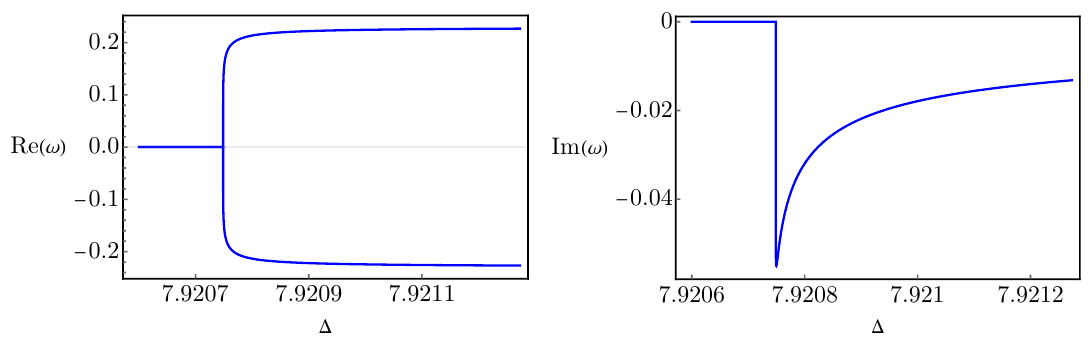
Figure 4 . Real and imaginary part of the frequency of the lowest lying QNM as a function of the parameter (cid:1).